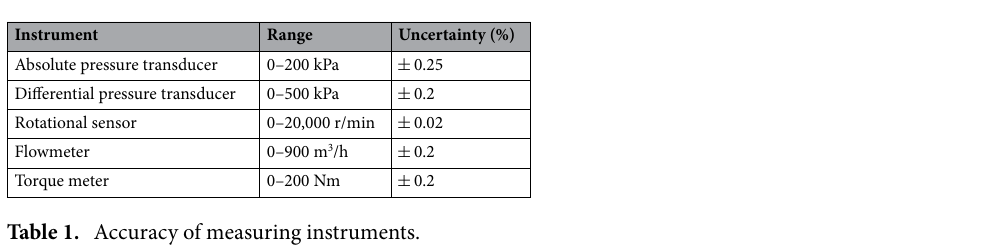
Table 1. Accuracy of measuring